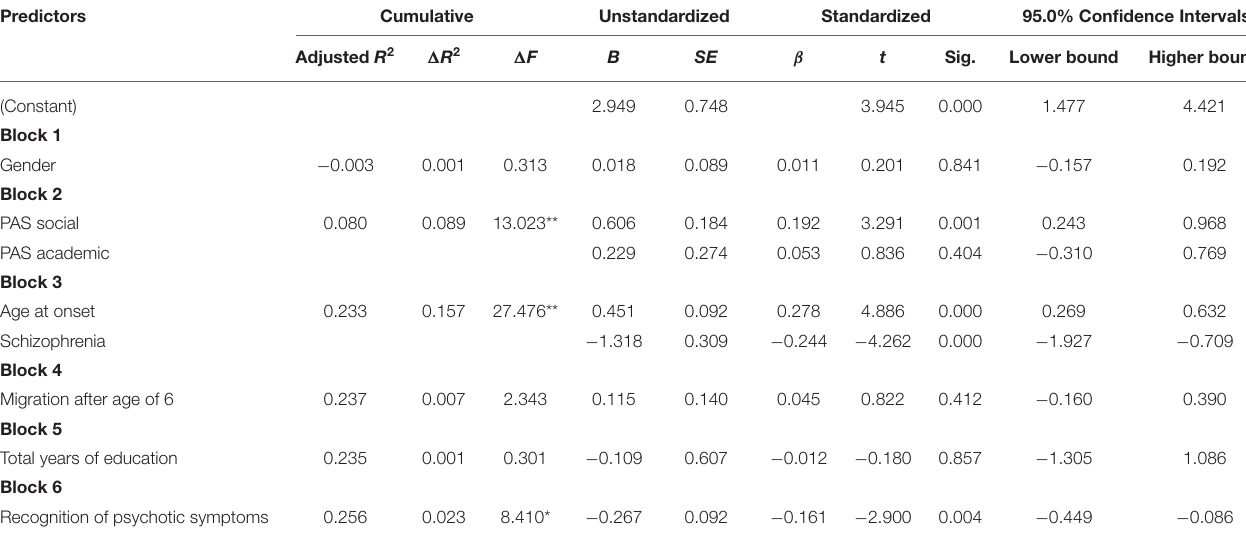
TABLE 5 | Hierarchical regression predicting duration of untreated psychosis